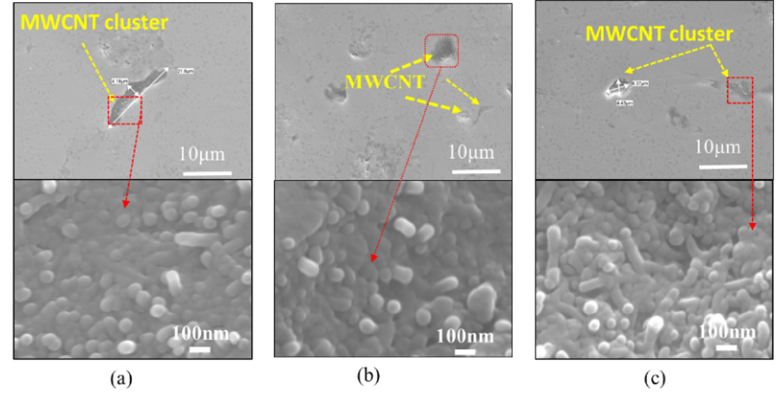
Figure 8. SEM Images of 80nFe-19Al-1MWCNT composites milled for: ( a ) 12 h; ( b ) 24 h and ( c ) 48 h.